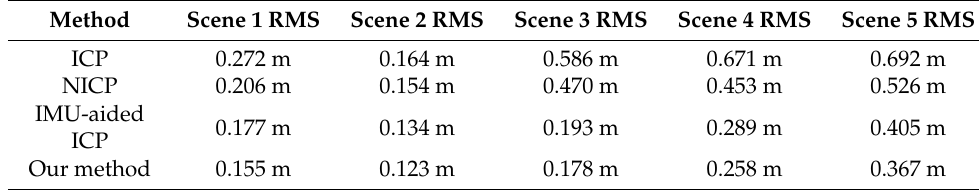
Table 3. Registration accuracy